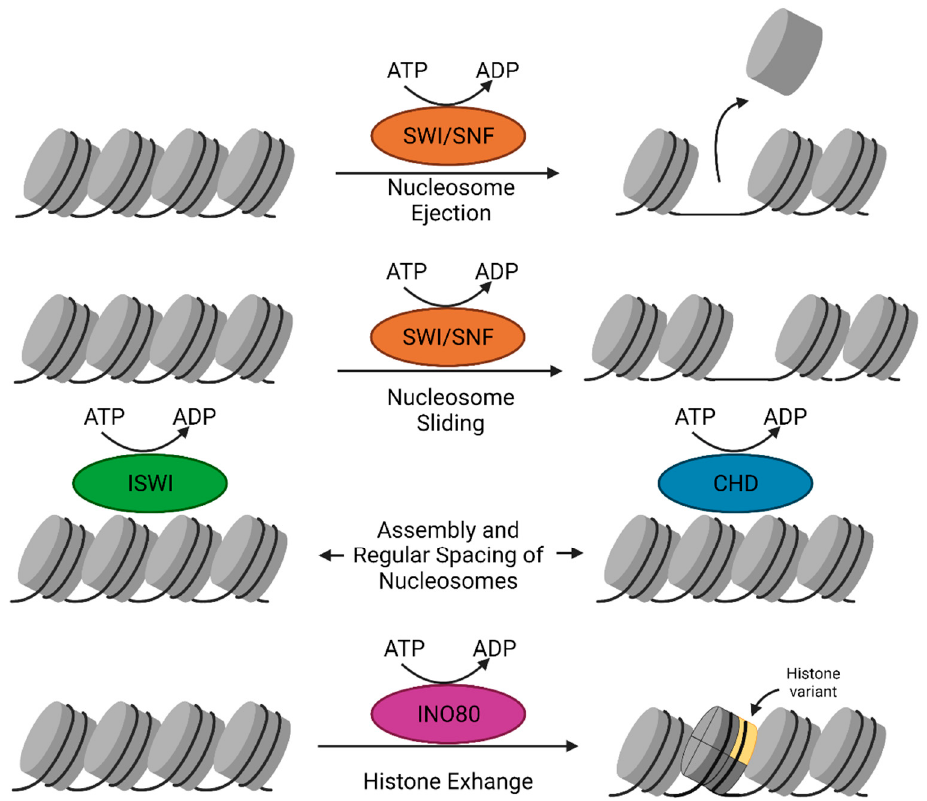
Figure 2. ATP-dependent chromatin remodelers. The SWI/SNF family of remodelers eject and slide nucleosomes to facilitate chromatin access. ISWI and CHD family remodelers assemble and regularly space nucleosomes. The INO80 family remodelers can have unique functions but are known to partake in histone variant exchange.